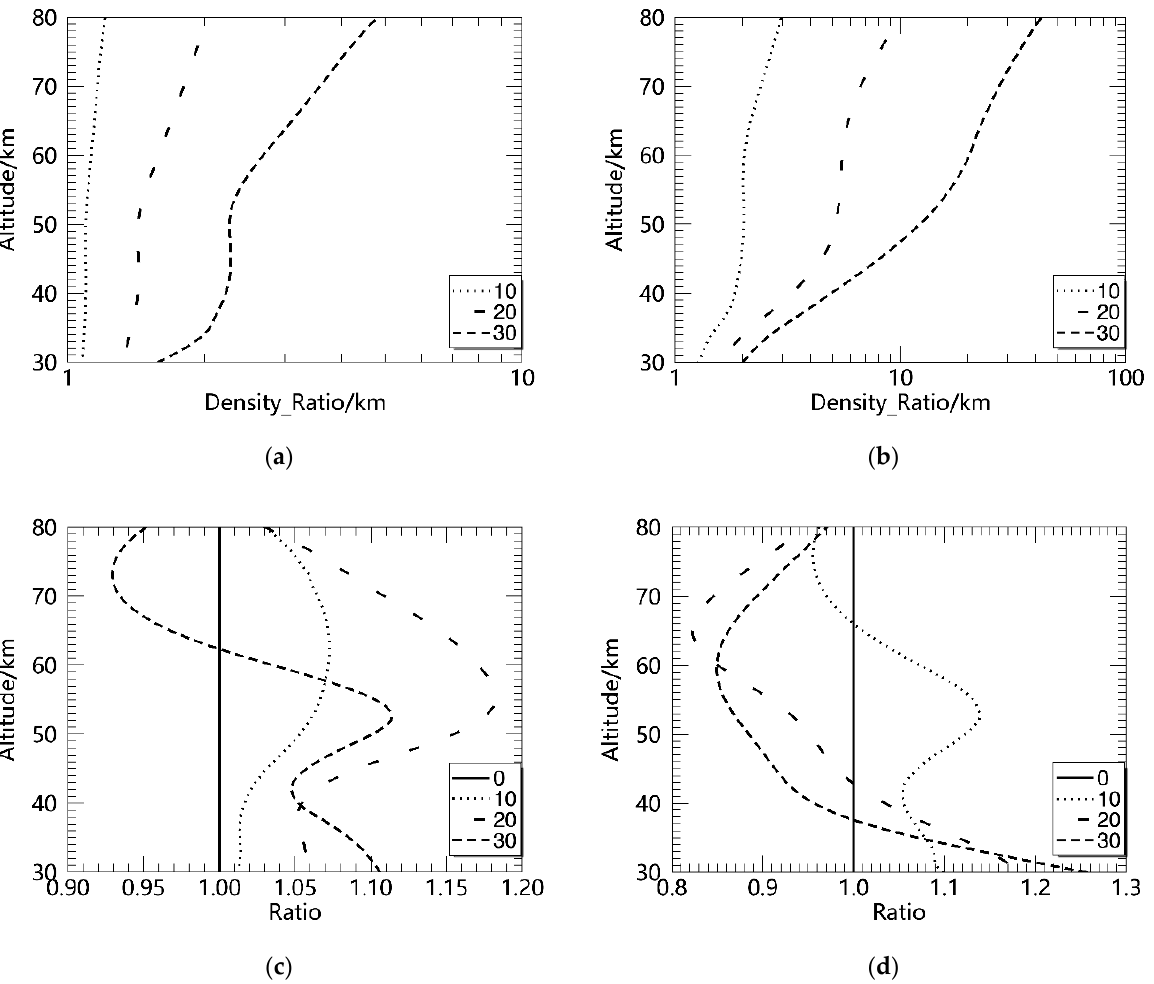
Figure 5. ( a ) The density ratio when the amplitudes of the roll angles are 10 ◦ , 20 ◦ , and 30 ◦ at θ 0 = 0 ◦ from 30 km to 80 km. ( b ) The density ratio when the amplitudes of the roll angles are 10 ◦ , 20 ◦ , and 30 ◦ at θ 0 = 30 ◦ from 30 km to 80 km. ( c ) The temperature ratio when the amplitudes of the roll angles are 10 ◦ , 20 ◦ , and 30 ◦ at θ 0 = 0 ◦ from 30 km to 80 km. ( d ) The temperature ratio when the amplitudes of the roll angles are 10 ◦ , 20 ◦ , and 30 ◦ at θ 0 = 30 ◦ from 30 km to 80